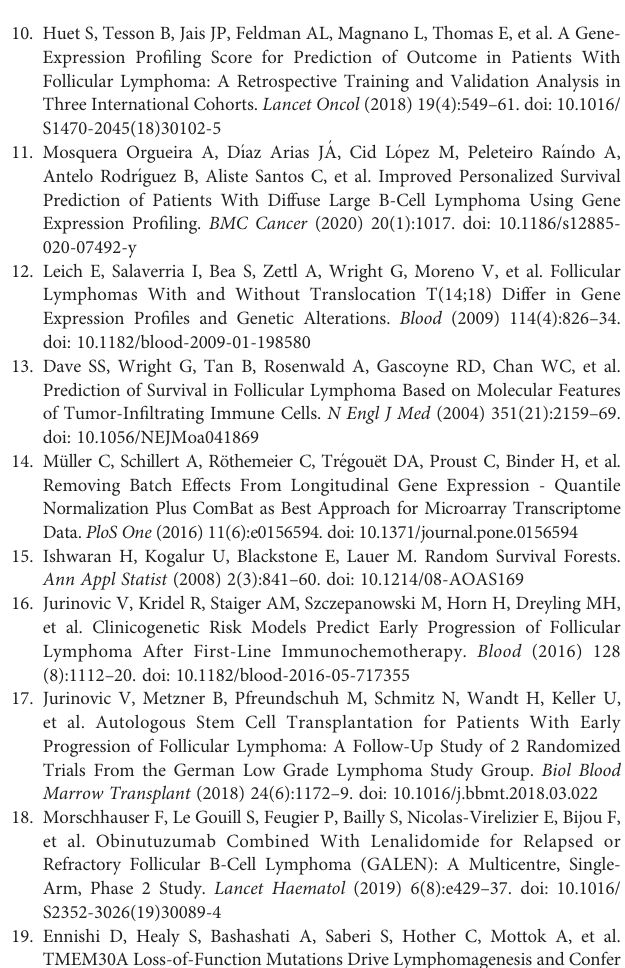
expected survival is represented in blue, and the 50% with lower